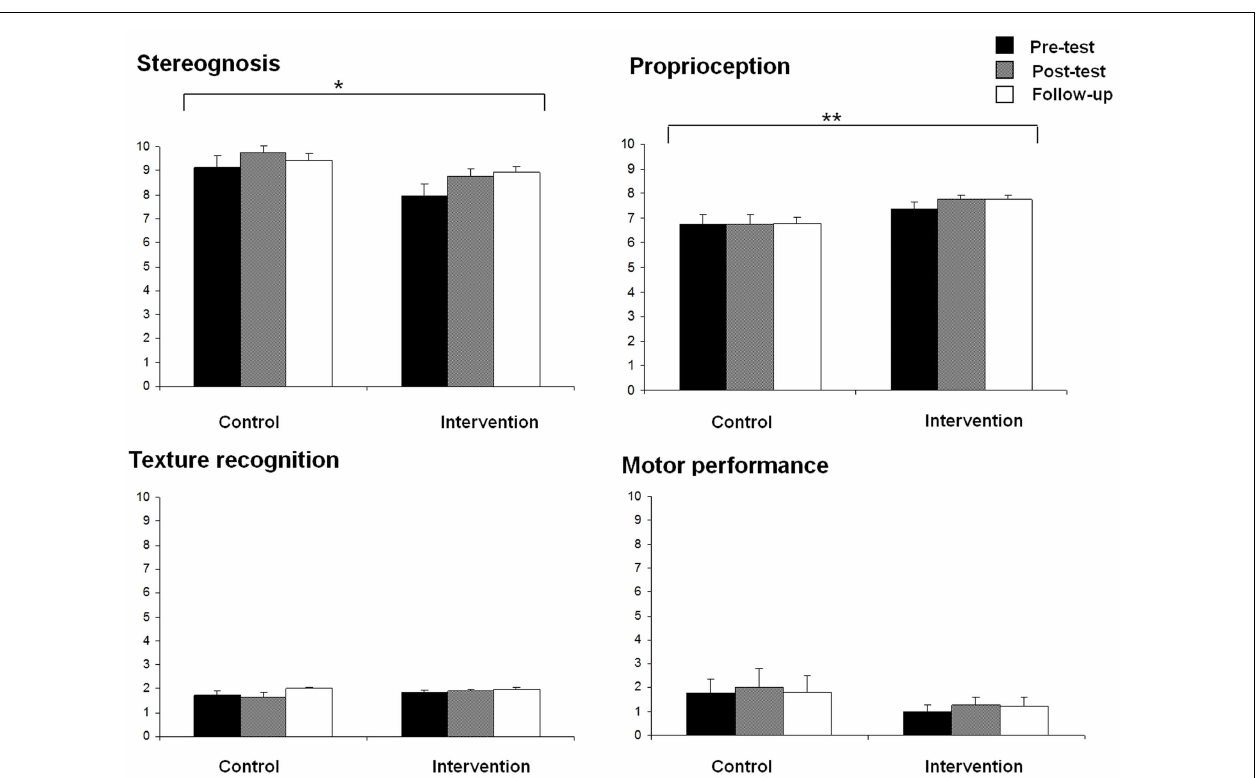
FIGURE 2 | Means of stereognosis, proprioception, texture recognition, and motor performance for each group (control and intervention) at all assessment times (pre-test, post-test, and follow-up) (* p < 0.05, ** p < 0.01) .